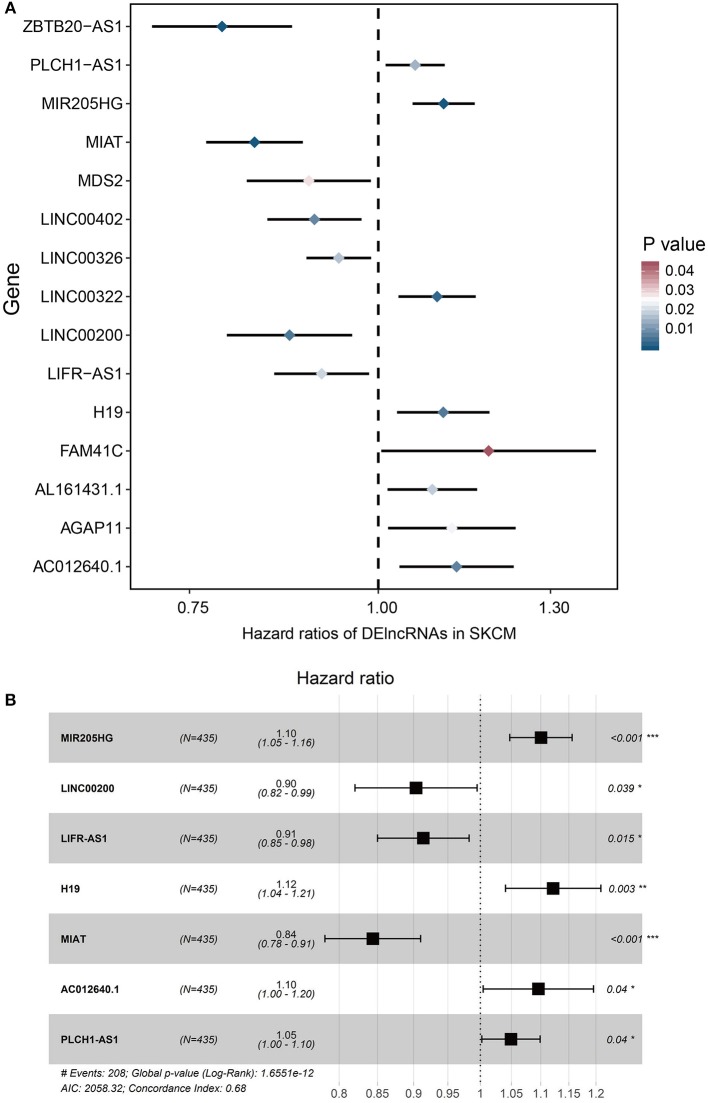
Cox regression analyses of DE lncRNAs based on the ceRNA network. (A) 15 DElncRNAs that were significantly correlated with overall survival derived from the univariable Cox regression analysis in melanoma patients. (B) 7 DElncRNAs that were significantly correlated with overall survival derived from the multivariate Cox regression analysis in melanoma patients.